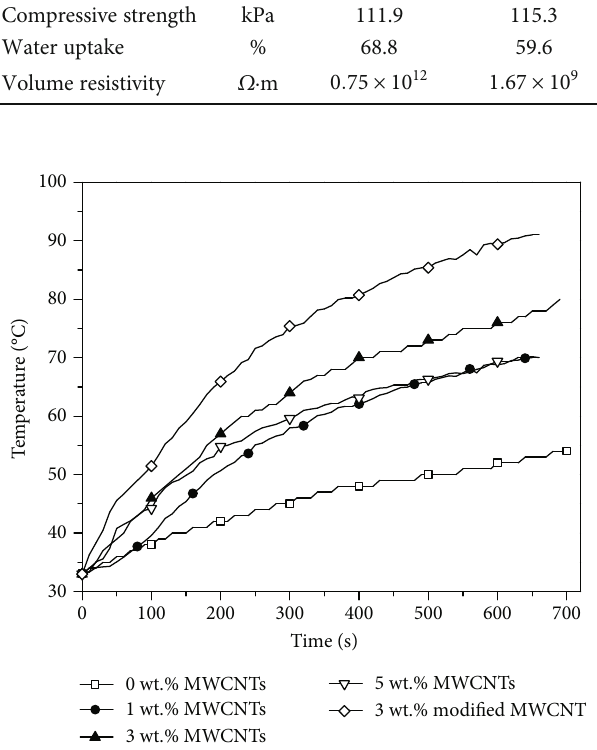
Figure 3: Temperature on the surface of the foam nanocomposites with di ff erent MWCNT